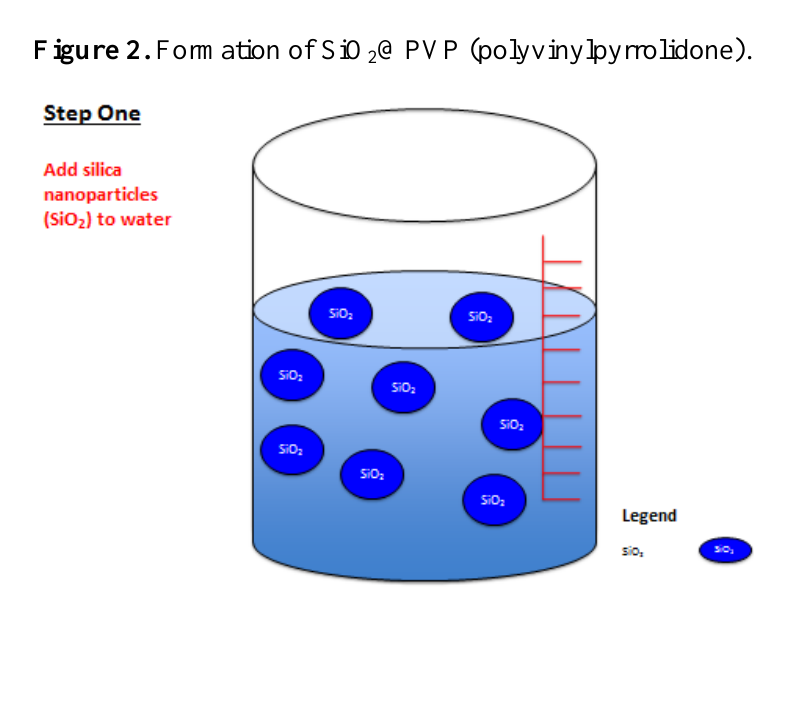
Figure 2. Formation of SiO